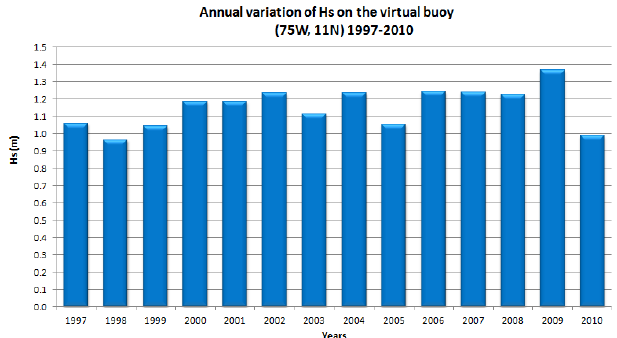
Fig. 12. Annual variation of the significant wave height of the vir- tual buoy.